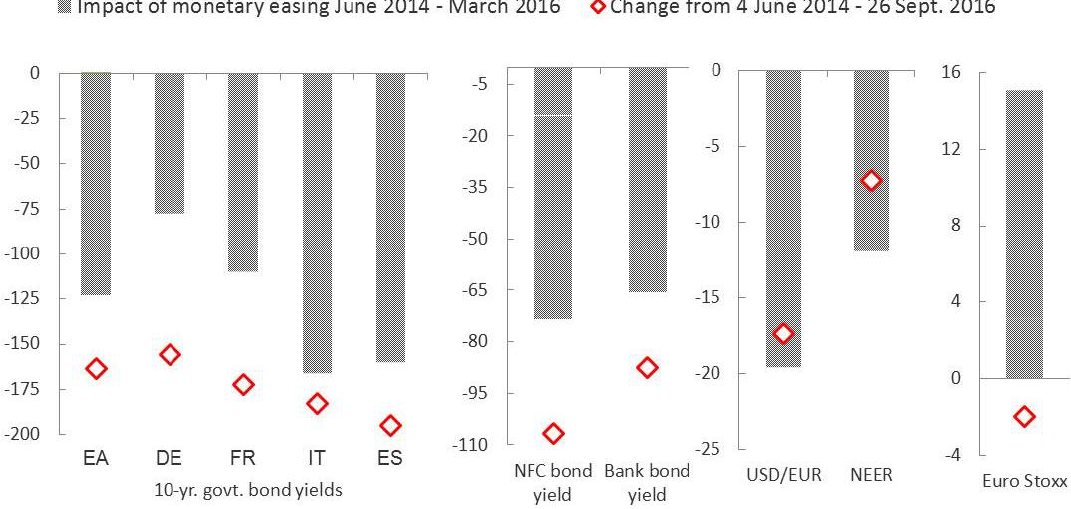
Figure 6. Asset price changes and the impact of ECB monetary easing (changes in basis points for bond yields, in percent for exchange rates and stock prices). Source: Bloomberg, ECB calculations. Note: The impact of monetary easing measures from June 2014 to March 2016 is estimated with econometric event studies, news analyses and model-based counterfactual exercises with a focus on announcement effects. See also (Altavilla et al. 2015) and (De Santis 2016). EA, DE, FR, IT and ES = Euro Area, Germany, France, Italy and Spain, respectively; NFC = non-financial corporations; USD/EUR = nominal euro exchange rate to the U.S. dollar; NEER = nominal effective exchange rate of the euro; Euro Stoxx = Dow Jones Euro Stoxx (broad) index.